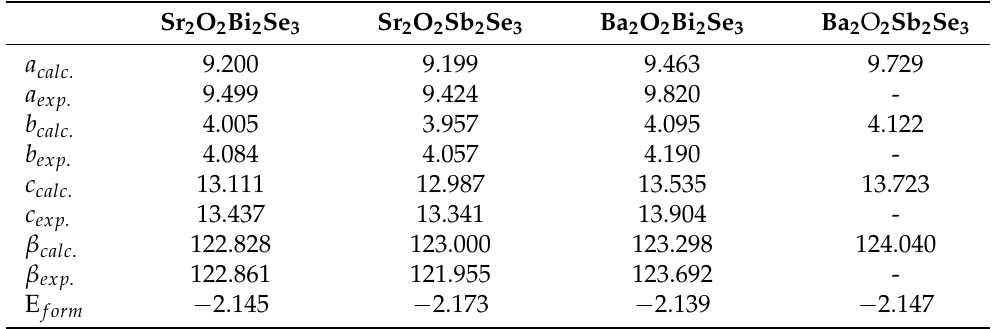
Table 1. Calculated lattice parameters a , b , c (Å), β ( ◦ ), formation energy, E form (eV) of the studied A 2 O 2 B 2 Se 3 (A = Sr, Ba and B = Bi, Sb) materials compared with the available experimental data from Reference [12]. α = γ = 90 ◦